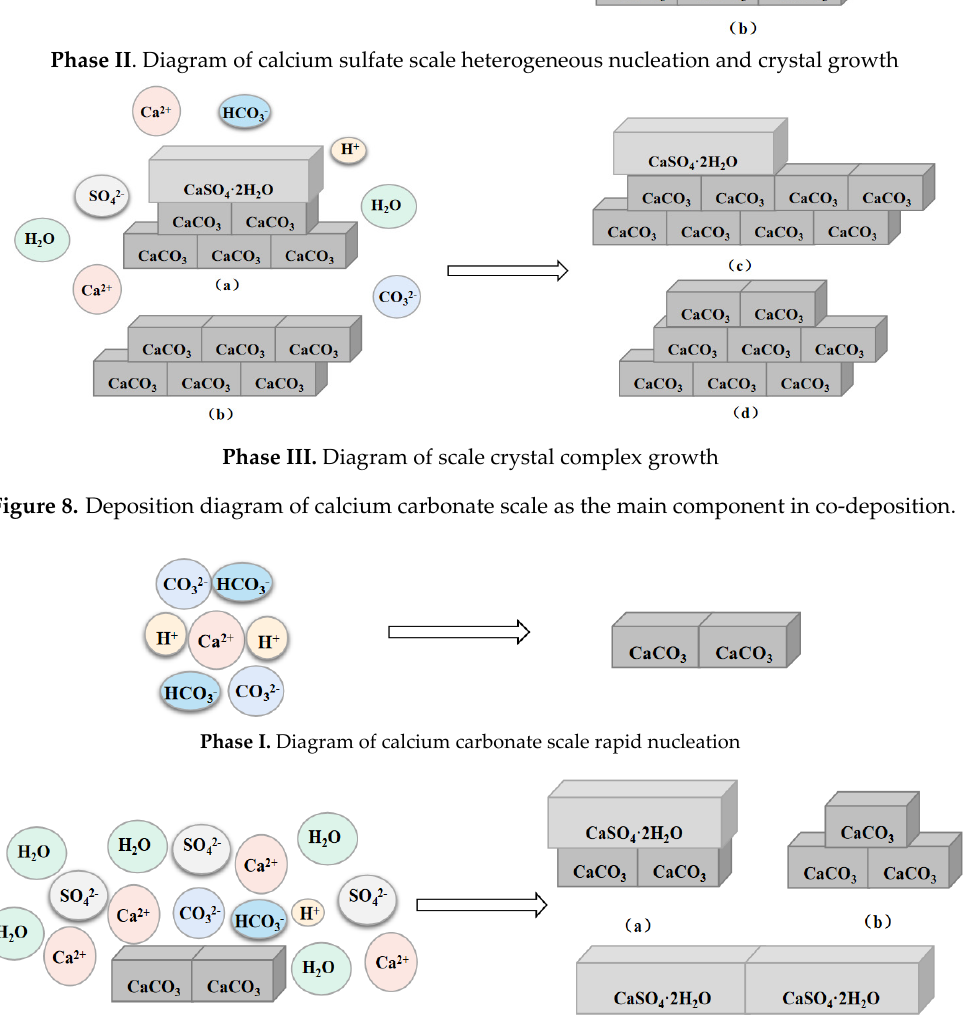
Figure 8. Deposition diagram of calcium carbonate scale as the main component in co-deposition.